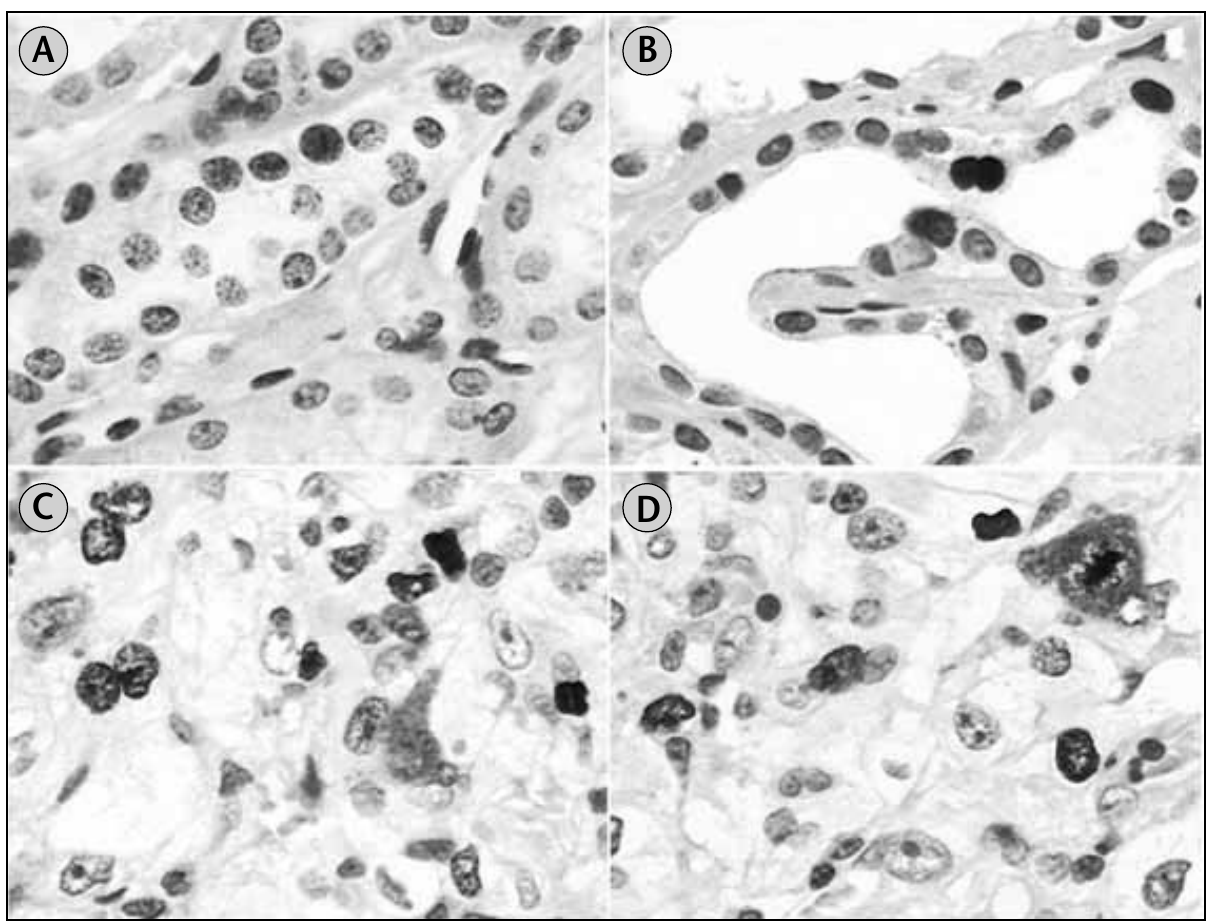
Figura 3 – (a) IHQ com o anticorpo antiproteína p53 – DIETR, marcação focal, objetiva de 40×; (b) IHQ com o anticorpo antiproteína p53 – DIETR, marcação moderada, objetiva de 40×; (c) IHQ com o anticorpo antiantígeno Ki-67 – DIETR, marcação difusa, objetiva de 40×; (d) IHQ com o anticorpo antiantígeno Ki-67 – DIETR com marcação focal, notar mitose positiva, objetiva de 40× IHQ: imuno-histoquímica; DIETR: displasia intraepitelial tubular